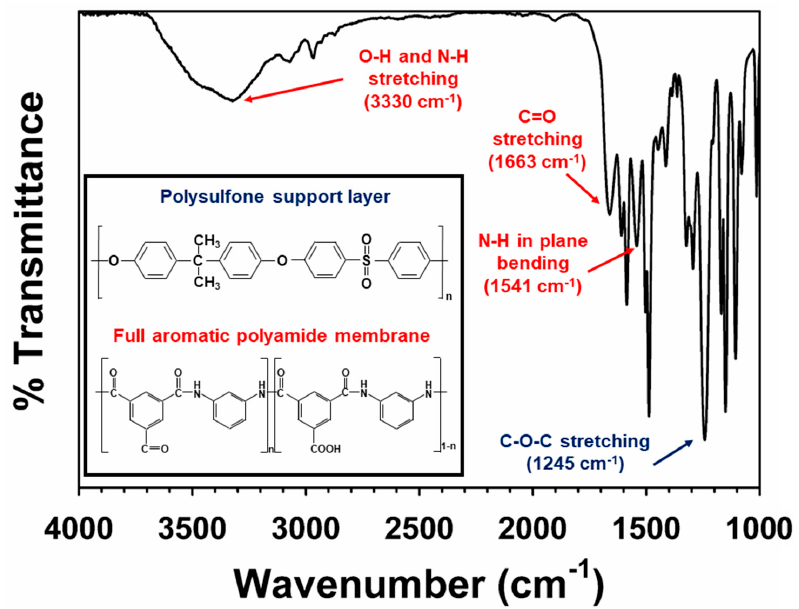
Figure 1. Intrinsic chemical structure of nanofiltration (NF) 90 membrane, as characterized by Fourier-transform infrared (FTIR).